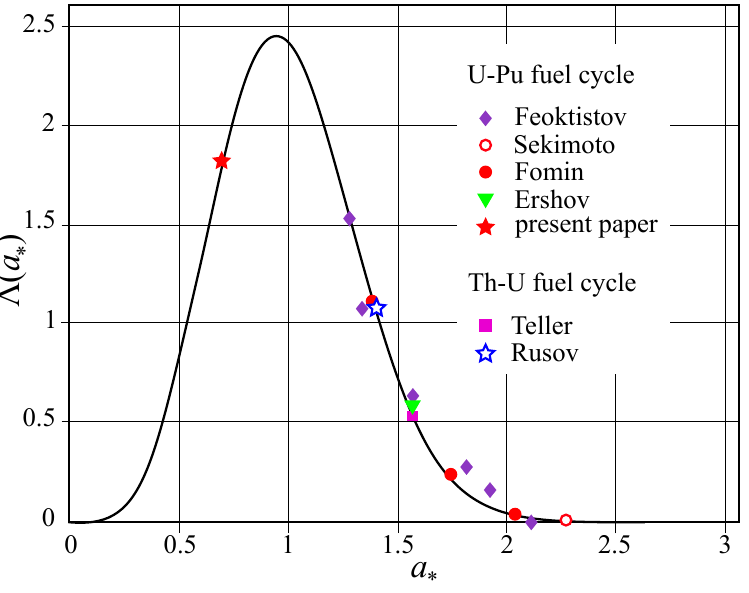
Figure 4. The theoretical (solid line) and calculational (points) dependence of Λ( a parameter a ∗